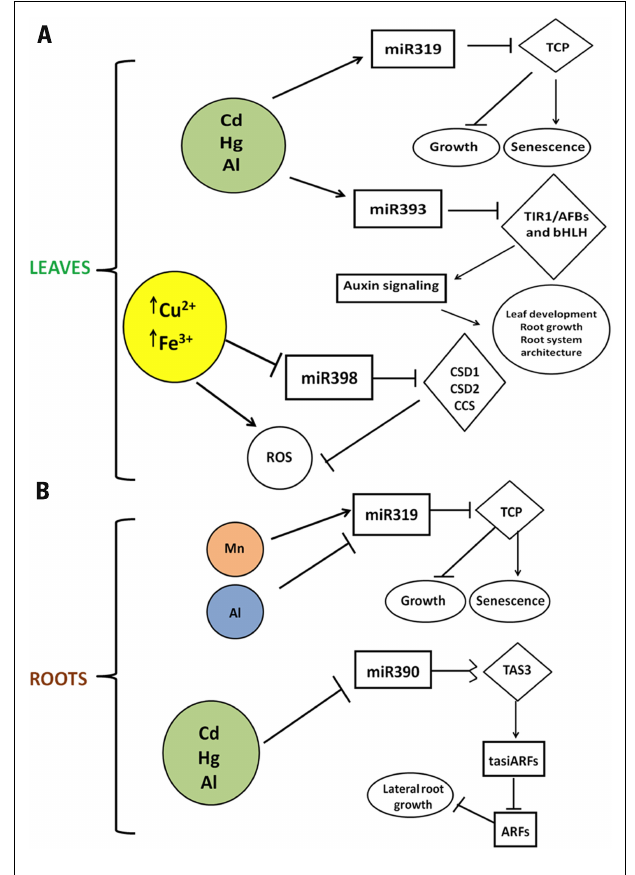
FIGURE 1 | Schematic representation of the mode of action of miR319, miR390, miR393, and miR398 in response to metal toxicity. (A) Regulation in leaves. (B) Regulation in roots. miRNAs are in rectangles while their targets are in diamonds. Arrows indicate up-regulation and blunted lines indicate